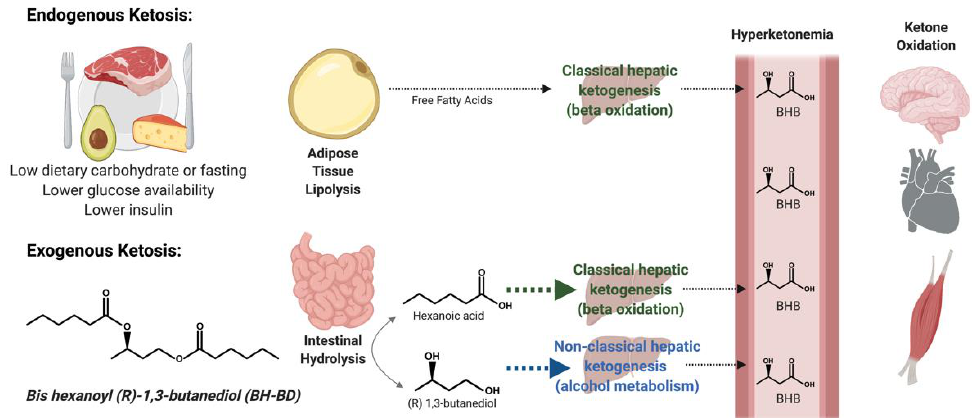
Figure 1. Schematic illustrating endogenous and exogenous ketosis and bis-hexanoyl-(R)-1,3-butanediol (BH-BD) metabolism. Created with Biorender.com. Abbreviations: BHB, beta-hydroxybutyrate.